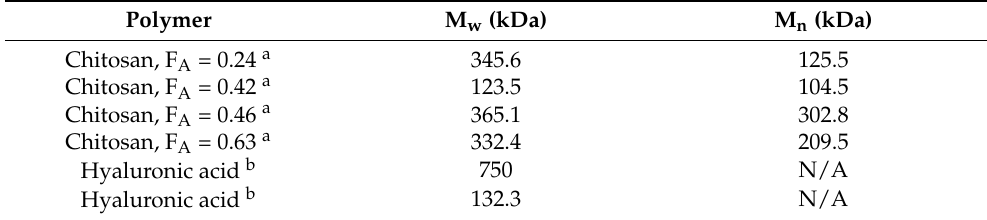
Table 1. Weight-average (M w ) and number-average (M n ) molecular weight of chitosan and hyaluronic